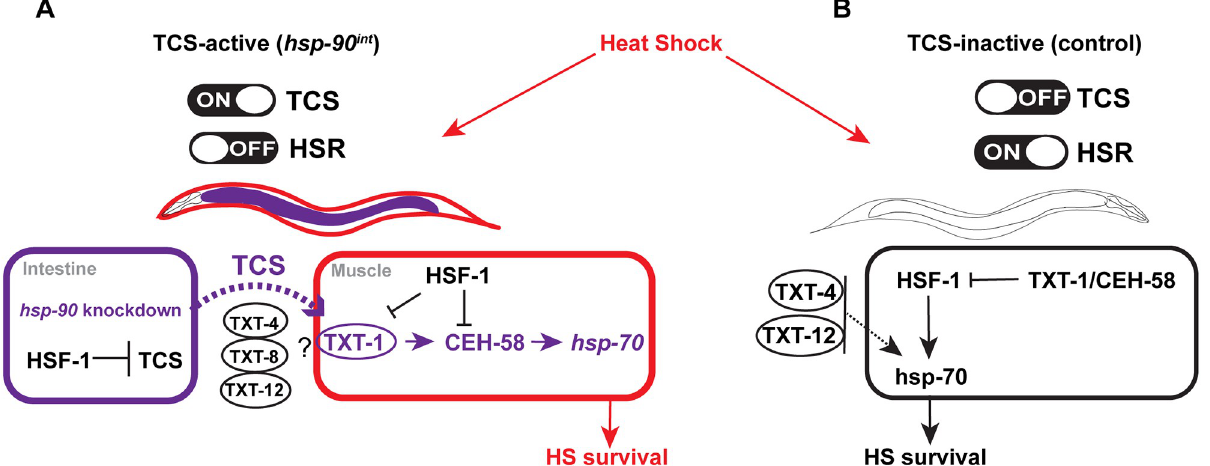
Fig 6. Proposed model explaining the opposing regulatory mechanisms of hsp-70 induction and survival in TCS-active compared to a TCS- inactive strain. ( A ) Upon hsp-90 RNAi in the intestine (“TCS-active”) hsp-70 is induced in the muscle via an hsf-1 -independent mechanism that depends on TXT-1/CEH-58 signaling in the muscle as well as extracellular peptides TXT-4, TXT-8, and TXT-12. HSF-1 functions as a suppressor of TCS-mediated hsp-70 expression and survival. ( B ) In control animals (“TCS-inactive”), cell nonautonomous hsp-70 induction and survival depends on HSF-1 and extracellular peptides TXT-4 and TXT-12 during HS; and is suppressed by TXT-1/CEH-58. HSF-1, heat shock factor 1; TCS, transcellular chaperone signaling.